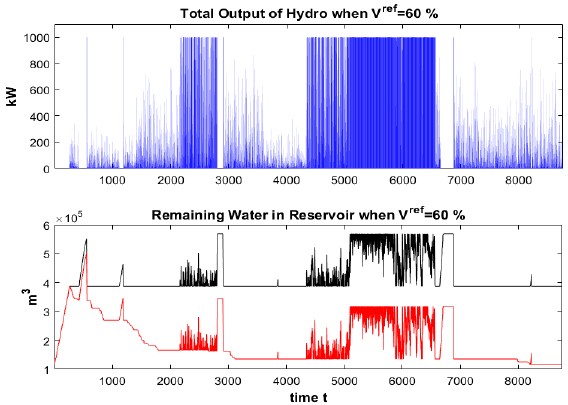
Figure 16. HPP Results under V ref = 60%.